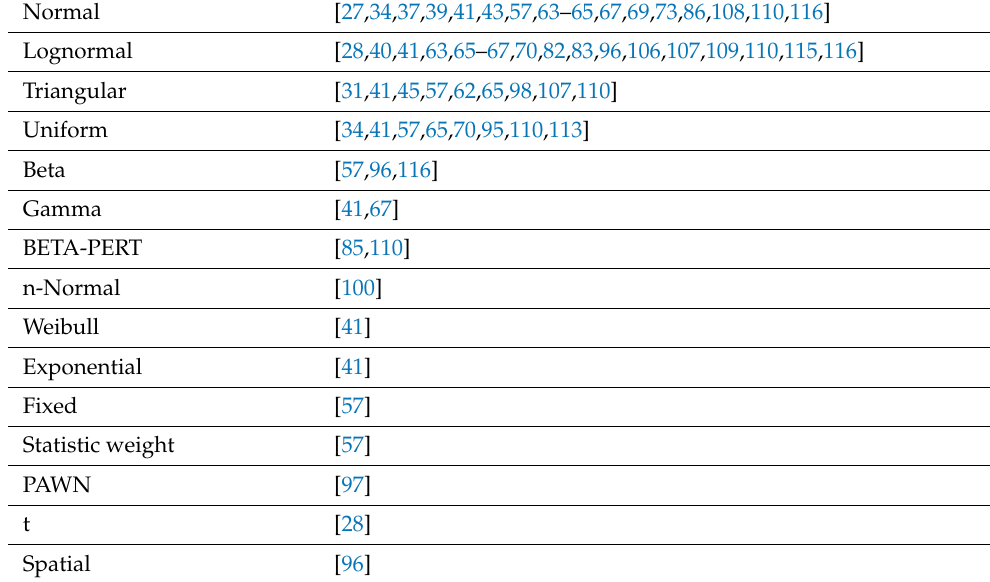
Table 7. Uncertain sources’ distribution functions.